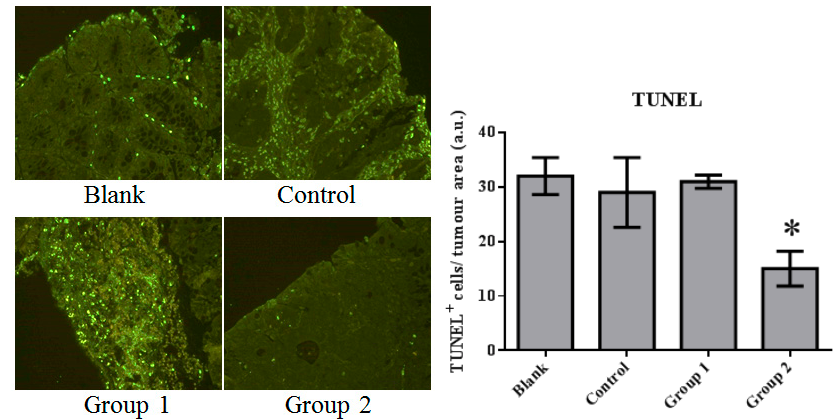
Figure 6. The TUNEL staining of colorectal tissue inspected under fluorescence microscopy. Apoptosis was significantly inhibited by the ASR extract treatment in the promotion stage (Group 2). The amount of sample in each group was n = 8 (blank group), n = 6 (control group), n = 7 (Group 1), n = 7 (Group 2). p > 0.05 and * p < 0.05 when compared with the control group.